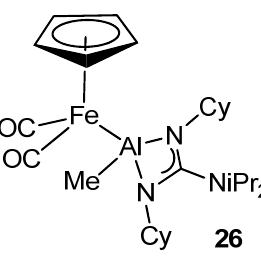
Figure 19. Bimetallic iron–aluminum compound.